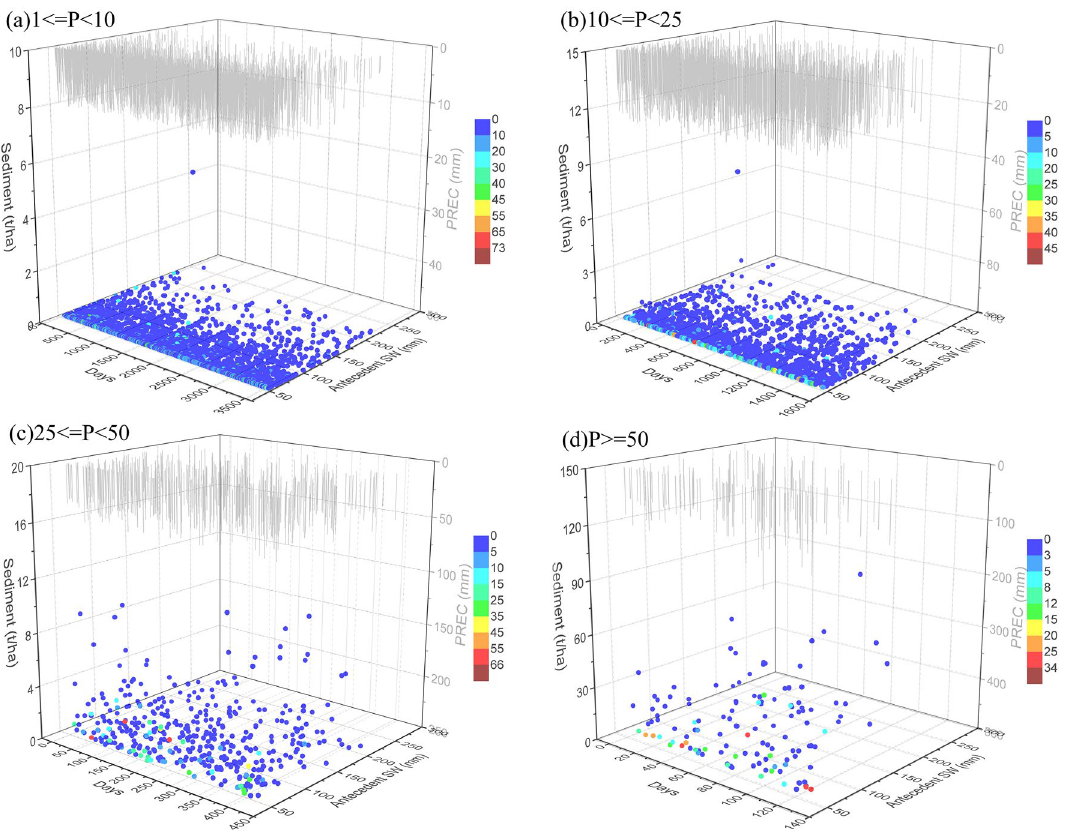
Figure 8. Relationship of sediment load with precipitation (PREC, mm), antecedent drought days, and antecedent soil water (antecedent SW, mm) at different precipitation amounts: ( a ) light rain (1 ≤ P < 10 mm), ( b ) moderate rain (10 ≤ P < 25 mm), ( c ) heavy rain (25 ≤ P < 50 mm), and ( d ) rainstorm (P ≥ 50 mm). Graphs were created using OriginPro software version 9.0 (https:// www. origi nlab.